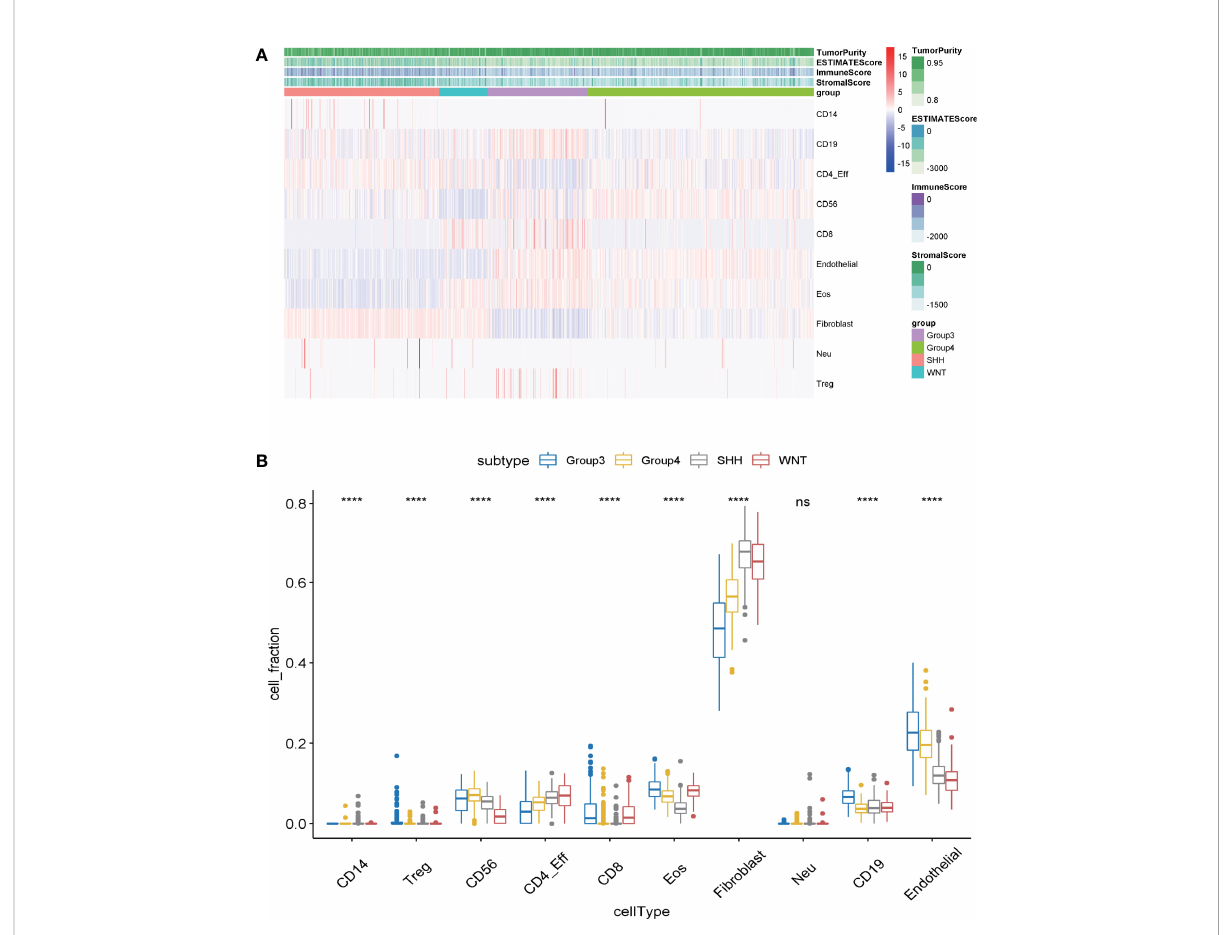
FIGURE 1 (A) The in fi ltration degree of in fi ltrating cells in medulloblastoma samples was evaluated by MethylCIBERSORT deconvolution. The abscissa represents medulloblastoma samples, and the ordinate represents the cells existing in tumor samples for identi fi cation. (B) The differences of immune cell infection among the four subgroups of medulloblastoma were analyzed by one-way ANOVA. Abscissa: the in fi ltrating cells identi fi ed in tumor samples; ordinate: the proportion of each type of cell in tumor tissue. ns, p > 0.05; ****p ≤